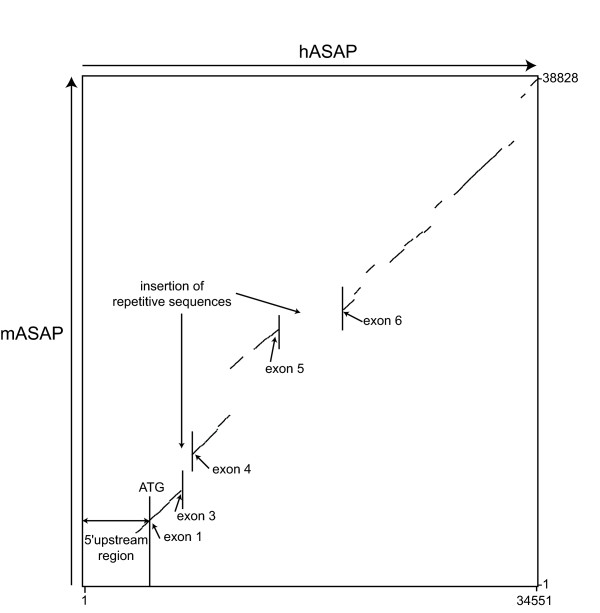
Dot plot of the percent identity plot (PIP) analysis of human and mouse ASAP gene regions. The human ASAP sequence (hASAP) is represented on the x-axis, and the mouse sequence (mASAP) on the y-axis. The ATG start codon and the 5' upstream region are indicated, showing that the two genes are conserved for ~1 kb upstream the coding region. Introns differ between the two species by homology losses due to large insertion/deletion of repeats as examplified between exons 3 and 4, and exons 5 and 6.